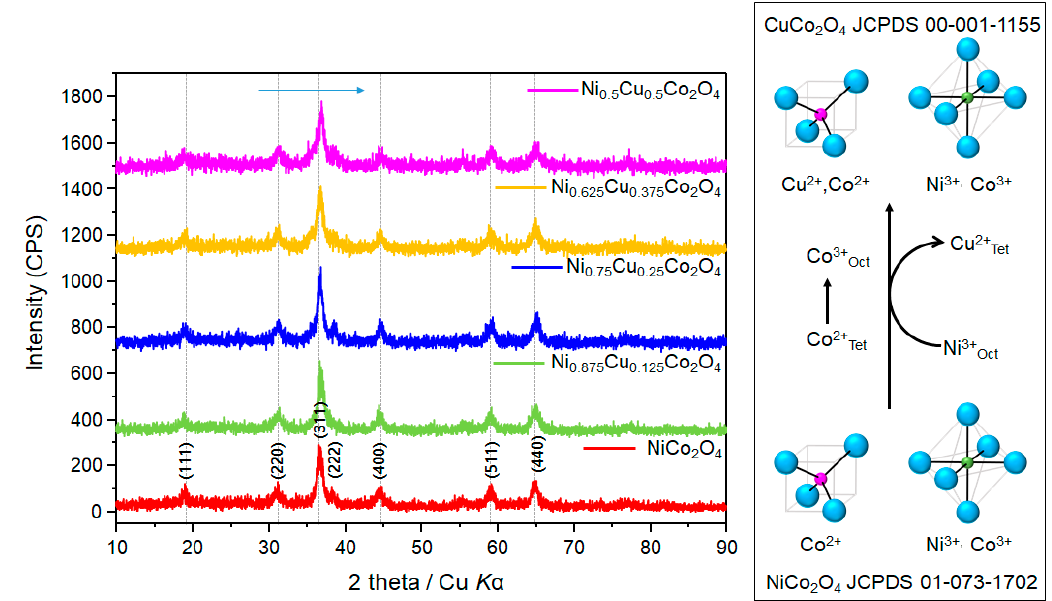
Figure 1. XRD pattern of synthesized Ni 1 − x Cu x Co 2 O 4 active materials.